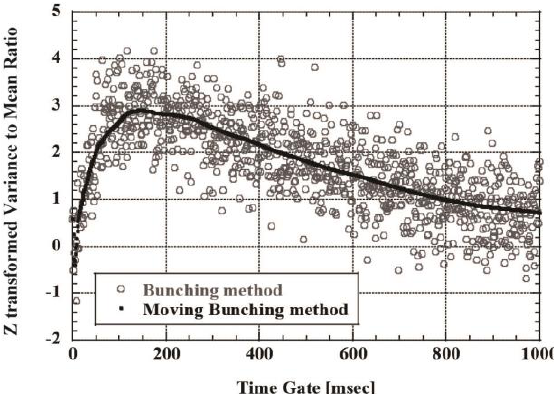
Figure 5. An example of comparison of the Z transformed results of bunching method and moving bunching